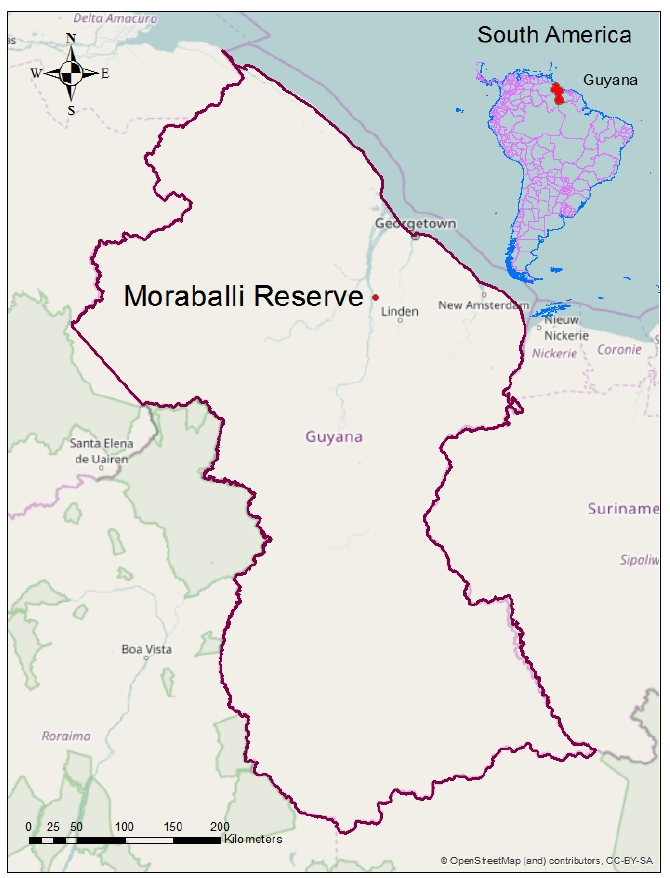
Figure 1. MAP of the Moraballi Reserve, Guyana [13].